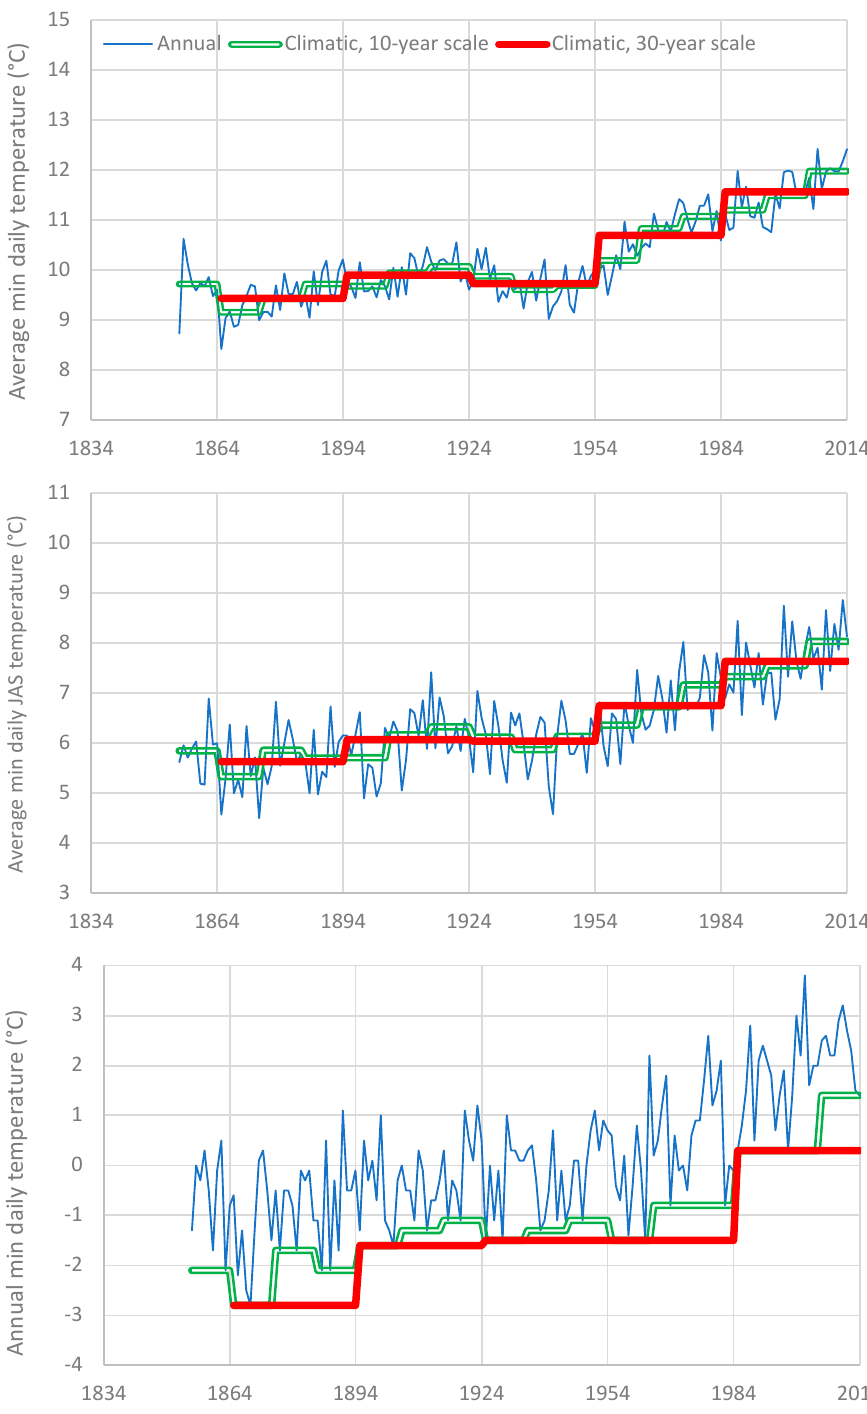
Figure A2. ( upper ) Evolution of annual average of minimum daily temperature in Melbourne, as a climatic element, seen at the annual and the climatic time scales of 10 and 30 years; ( middle ) as in upper panel but for a time window of the three summer months, JAS; ( lower ) as in upper panel but for the annual minimum of minimum daily temperature.